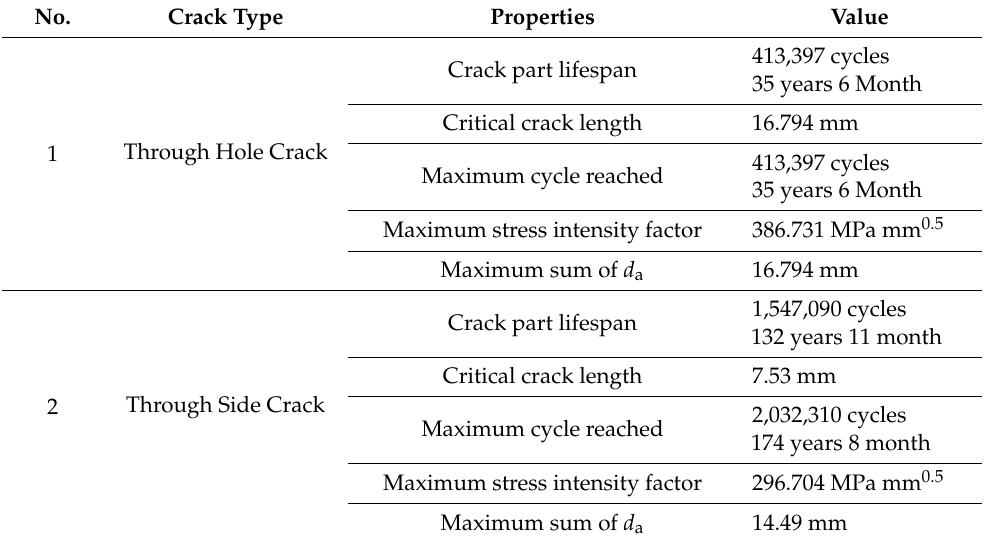
Table 5. Summary of